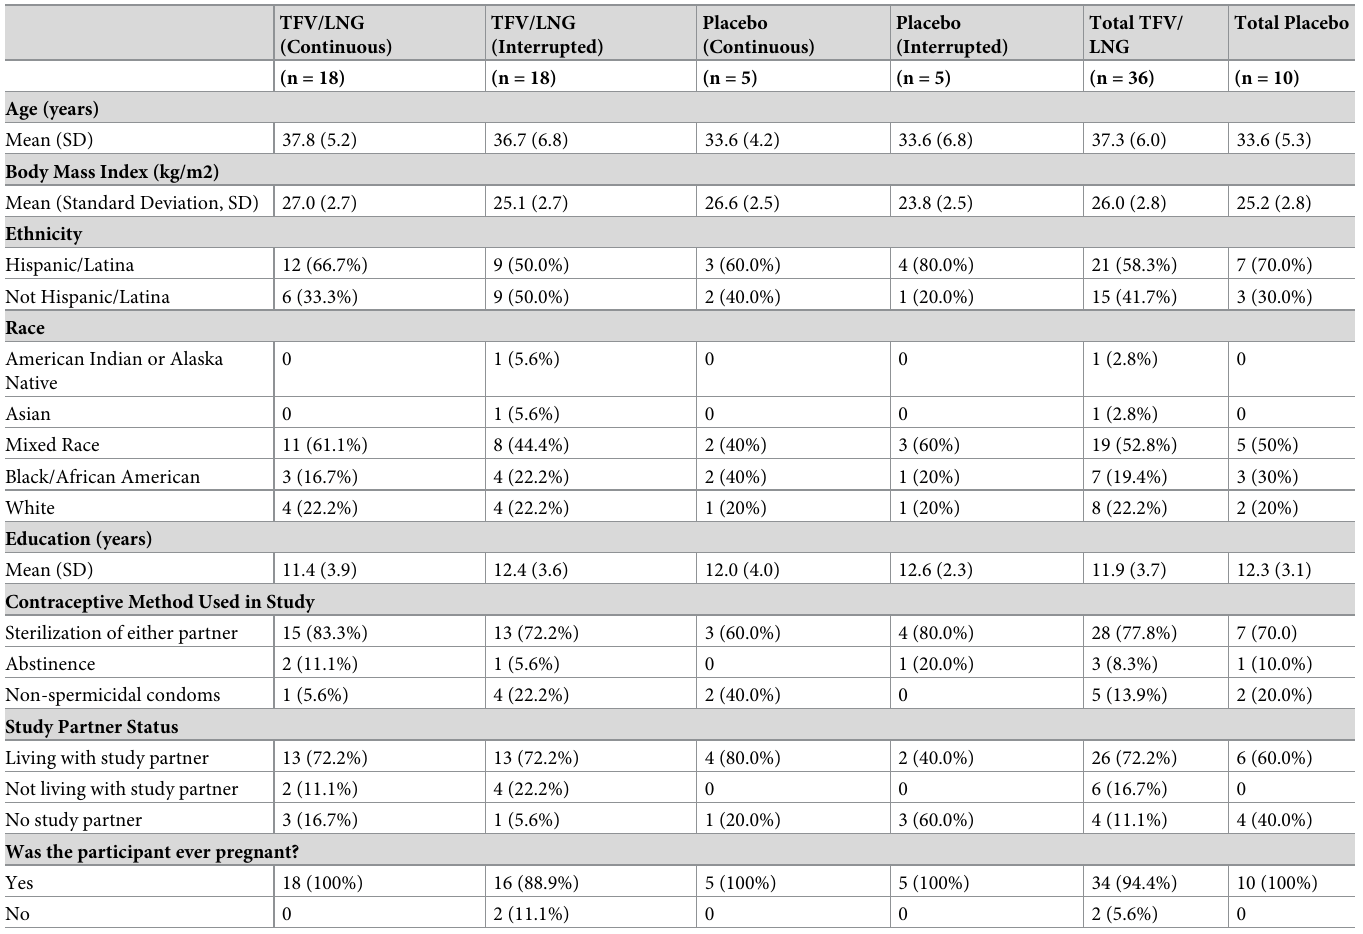
Table 1. Demographic and baseline characteristics treated